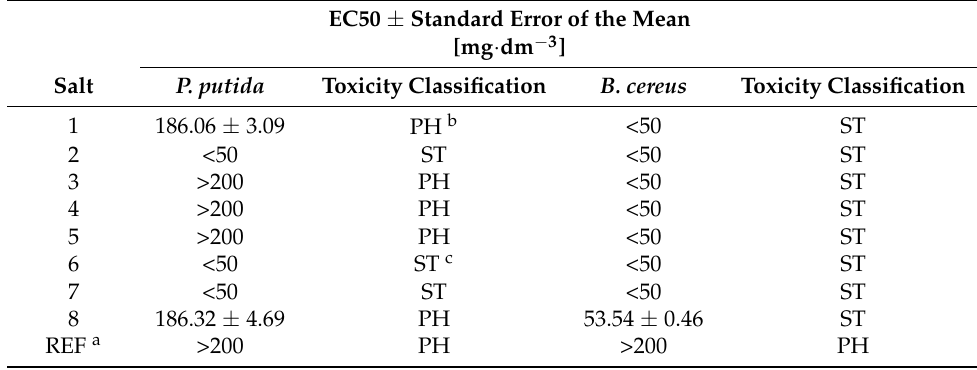
Table 3. Half-Maximal Effective Concentrations (EC 50 ) of the iodosulfuron-methyl-based salts. EC50 ± Standard Error of the